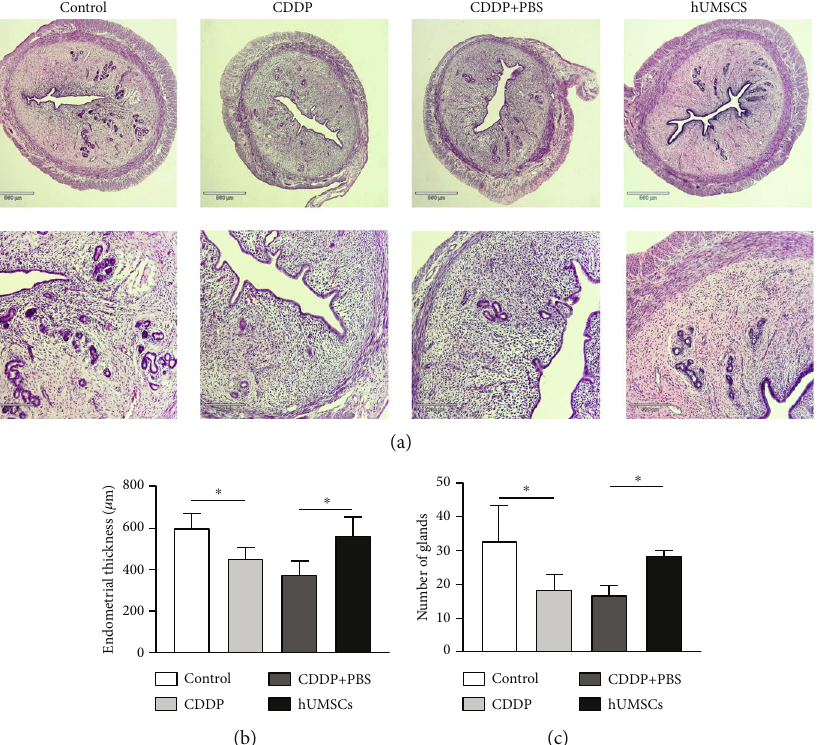
Figure 1: Uterine morphological characteristics. (a) Uterine tissue was examined microscopically following H&E staining in each group (40 × , 100 × ). (b) Changes in endometrial thickness in each group. (c) Number of endometrial glands in the uterus of each group. Data are presented as the means ± SDs . ∗ P < 0 : 05, ∗∗ P < 0 : 01, and ∗∗∗ P < 0 : 001 . CDDP: cisplatin; H&E: hematoxylin and